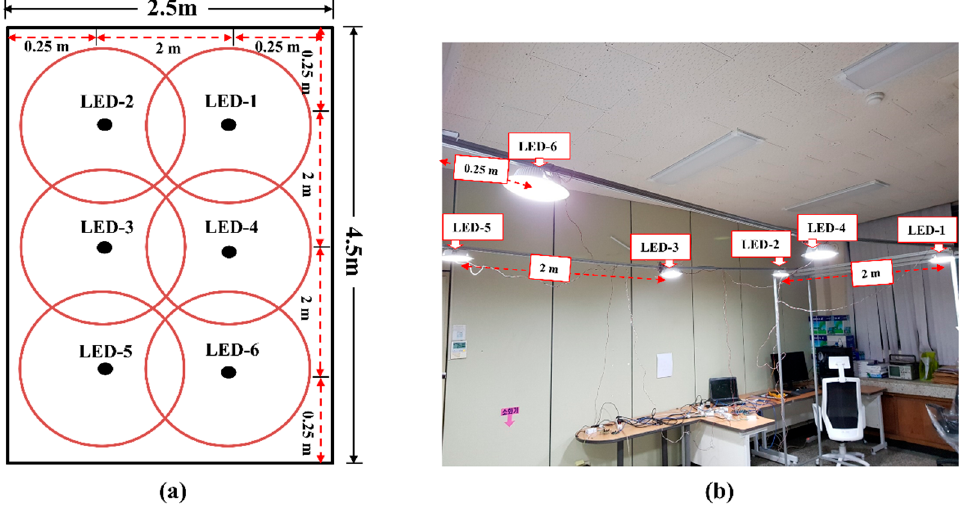
Figure 9. Experimental setup: ( a ) VLP installation area; ( b ) test field